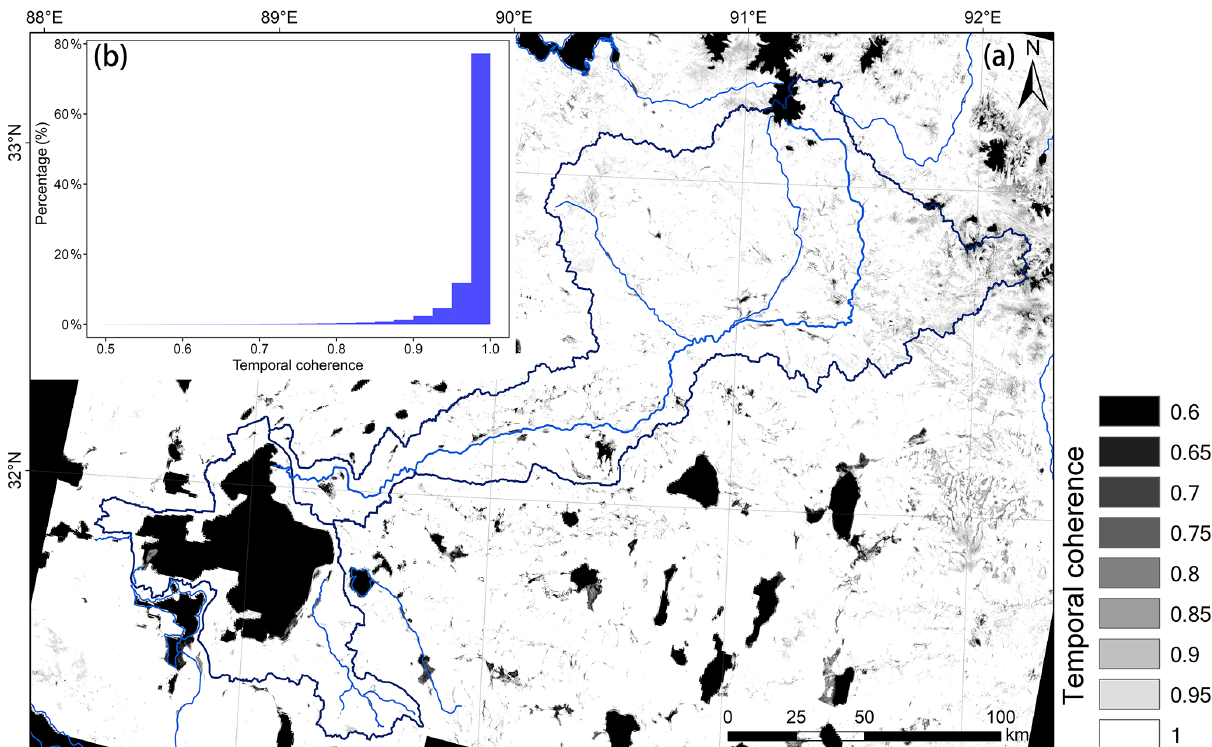
Figure 10. (a) Map of temporal coherence (Eq. 5). (b) Histogram illustrating the distribution of temporal coherence values within the Selin Co watershed excluding glaciers and